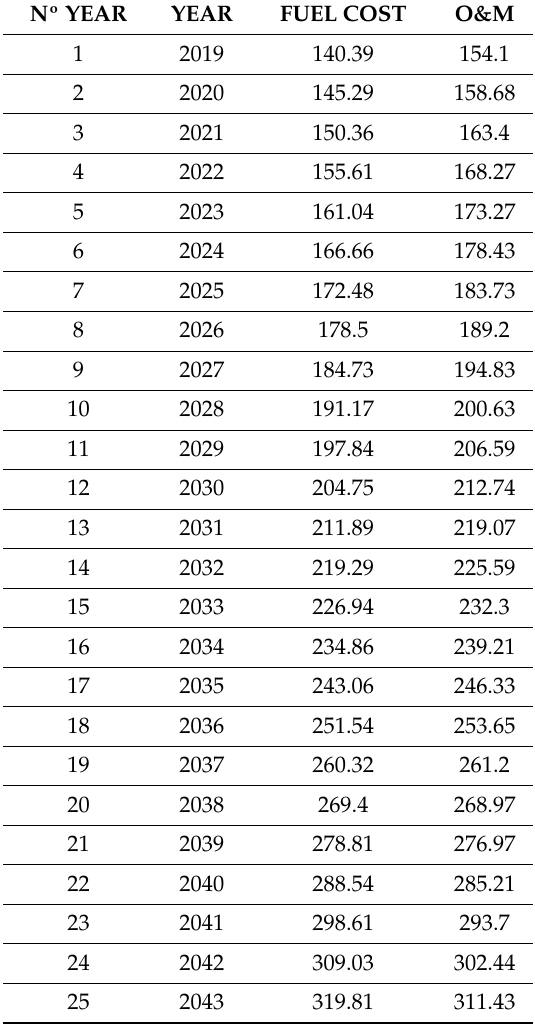
Table A8. Fuel cost and operating and maintenance costs (O&M) of the plant (in millions of